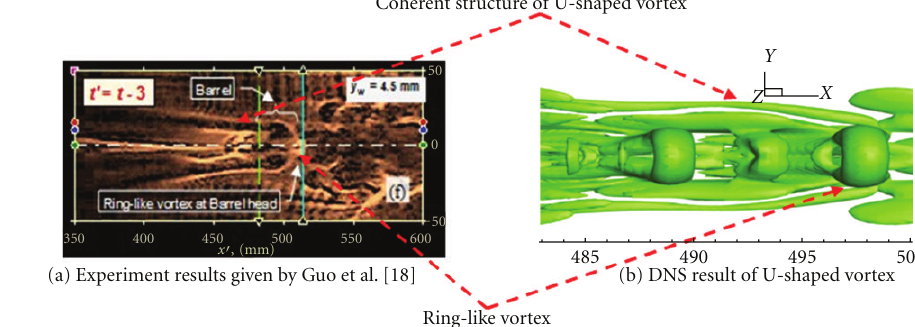
Figure 12: Qualitative vortex structure comparison with experiment.